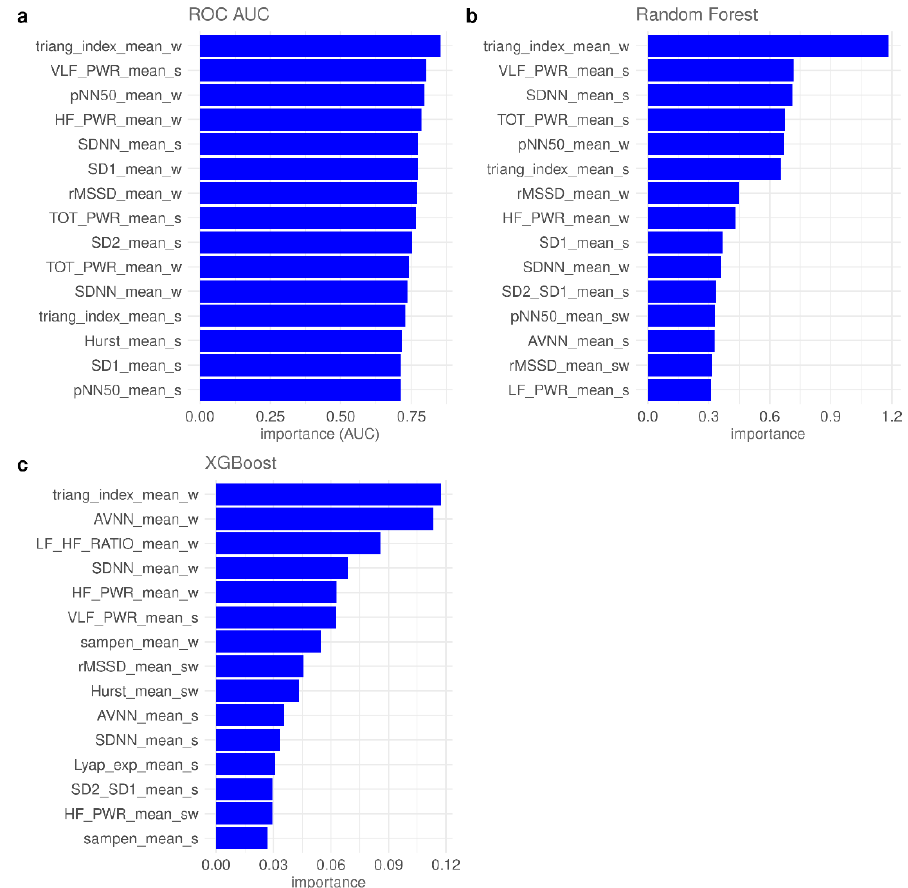
Figure 1. Box Plots of cardiac sympathetic ( A ) and parasympathetic ( B ) index in iRBD patients and controls. Each whisker extends to the most extreme data point (excluding outliers); the lower boundary of each box represents the first quartile, while the upper boundary identifies the third quartile; the bold horizontal line is the median value. Outliers are represented as small circles above or below whiskers. HC: Healthy Controls; iRBD: idiopathic REM Sleep Behavior Disorder; LF: power in the 0.04–0.15 Hz band; HF: power in the 0.15–0.4 Hz band.